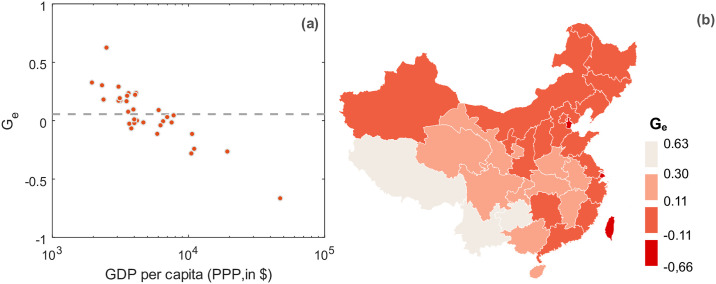
Sub-national inhomogeneity index Ge.We calculated the Ge on the province level for China. In (a) the Ge-values are plotted against the corresponding province GDP per capita values on a logarithmic scale, analogous to Fig 4. The dashed line indicates the country-level mean Ge. Panel (b) shows a map of China where the provinces are color-coded according to the inhomogeneity index Ge. It can be seen that the development dependence as found in Fig 4 does also hold on the sub-national scale—at least in China. Provinces with lowest and highest Ge-values are Hong Kong and Tibet, respectively. Note, however, that for the USA we do not find sub-national correlations (S1 Fig in S1 File). (Data source of China level-1 administrative boundaries: https://www.naturalearthdata.com/downloads/10m-cultural-vectors/10m-admin-1-states-provinces/).